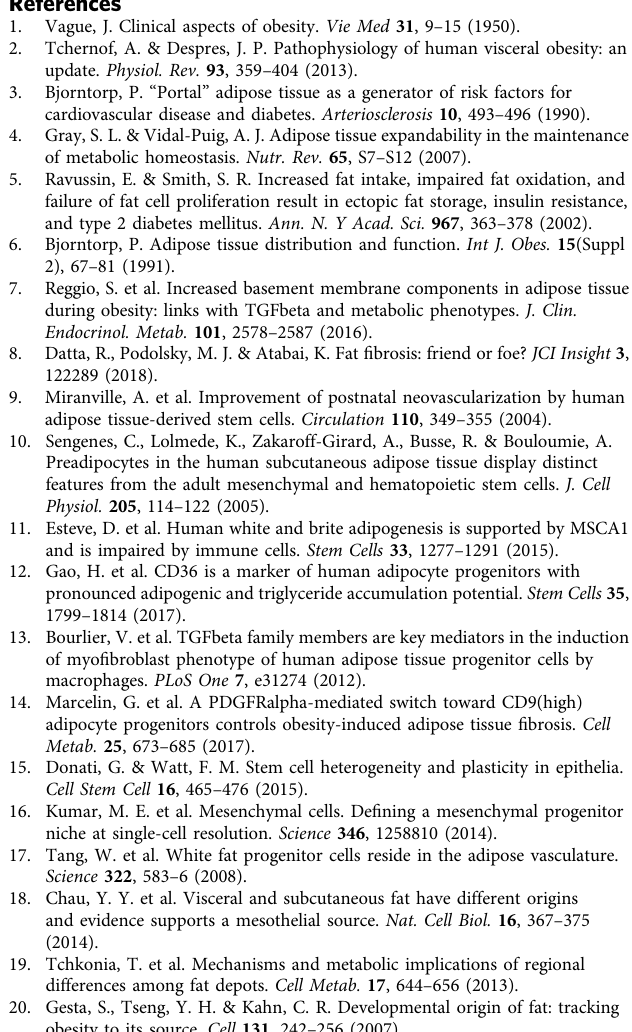
Fig. 8 Intrinsic differences in progenitor cell fate in SC and VSAT. a Principal component analysis performed on the percentage of progenitor cell subsets (determined by fl ow cytometry) from paired biopsies of subcutaneous (SC, black) and visceral (VS, red) AT according to BMI and waist circumference of n = 23 non-obese and n = 123 obese women. b Spearman correlation between the percentage of − / − cells and MSCA1 + cells or − /CD271 + cells in SCAT (black) and VSAT (red) ( n = 23 non-obese and n = 123 obese women). c Myo fi broblastic and adipogenic potential of obese SC and VSAT progenitor cells assessed by α SMA/DAPI staining and Bodipy staining, respectively. Representative immuno fl uorescence analyses performed on three independent donors. Scale bar: 100 µ m. d Progenitor cell number per gram of AT in non-obese ( n = 23) and obese ( n = 123) SC and VSAT, the results are means ± s.e. m. Two-way ANOVA followed by Tukey ’ s multiple comparison test, ** P < 0.01 and *** P < 0.001 comparing non-obese and obese subsets in the same AT location, ### P < 0.001 comparing SC and VS subsets of non-obese or obese individuals. e Distribution of mature adipocytes according to diameter in SC and VS lobules in n = 11 non-obese (upper panel) and n = 71 obese (lower panel) individuals, the results are means± s.e.m. Two-way ANOVA followed by Sidak ’ s multiple comparison test, ** P < 0.01. f Representative image of dissected lobules of matched SC and VSAT from obese donors and number of lobules per 100 mg of paired SC and VSAT, paired t test, ** P < 0.01 ( n = 11 independent donors). g Progenitor cell subset repartition in SC (left, black) and VS (right, red) AT from obese patients with (white bars, n = 57) or without ( fi lled bars, n = 66) a metabolic syndrome, the results are means± s.e.m. One- way ANOVA followed by Sidak ’ s multiple comparison test, ** P < 0.01, *** P